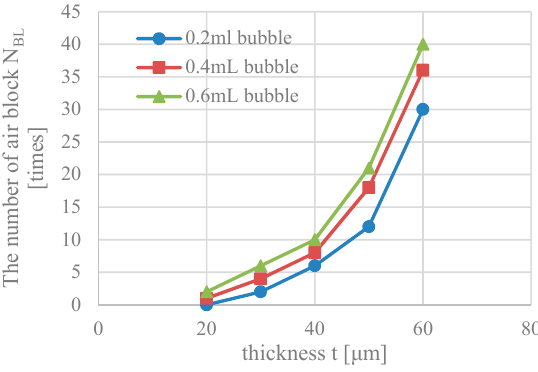
Figure 11. The relationship between thickness t and air block times N BL , when R D = 1.2. Micromachines 2015, 6, page–page